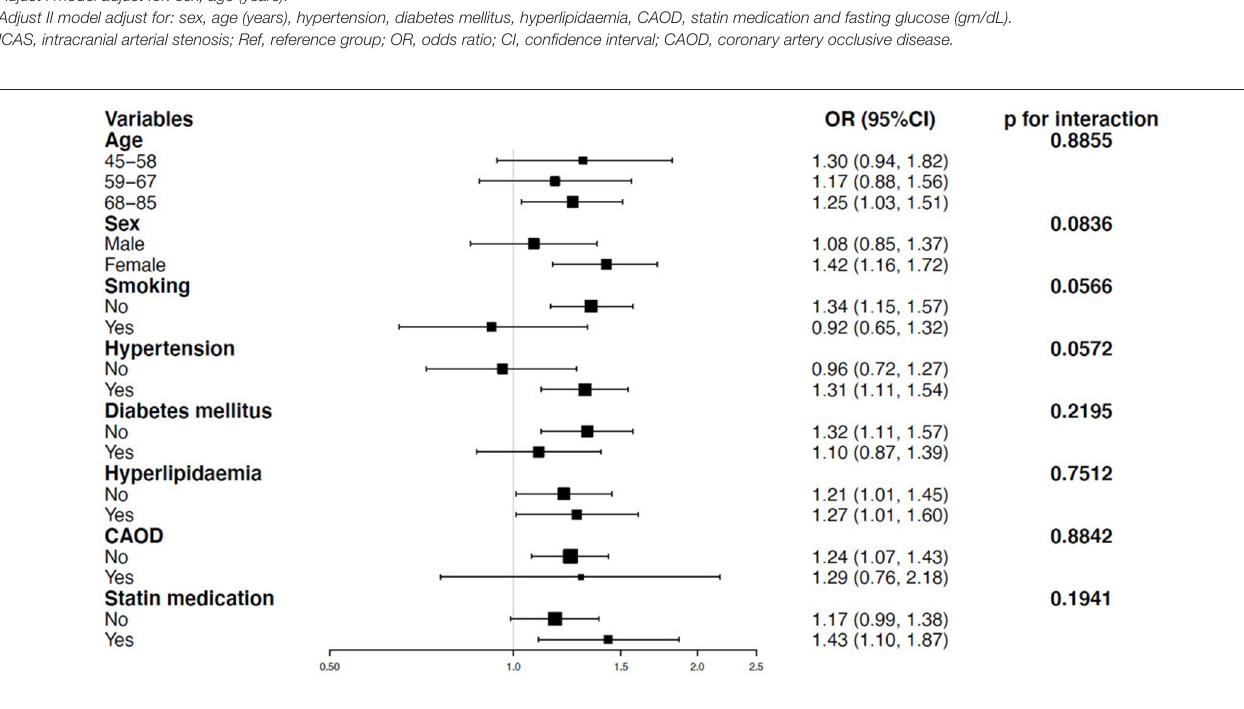
Logistic regression was performed for subgroup analysis. Adjust I model adjust for: sex, age (years).